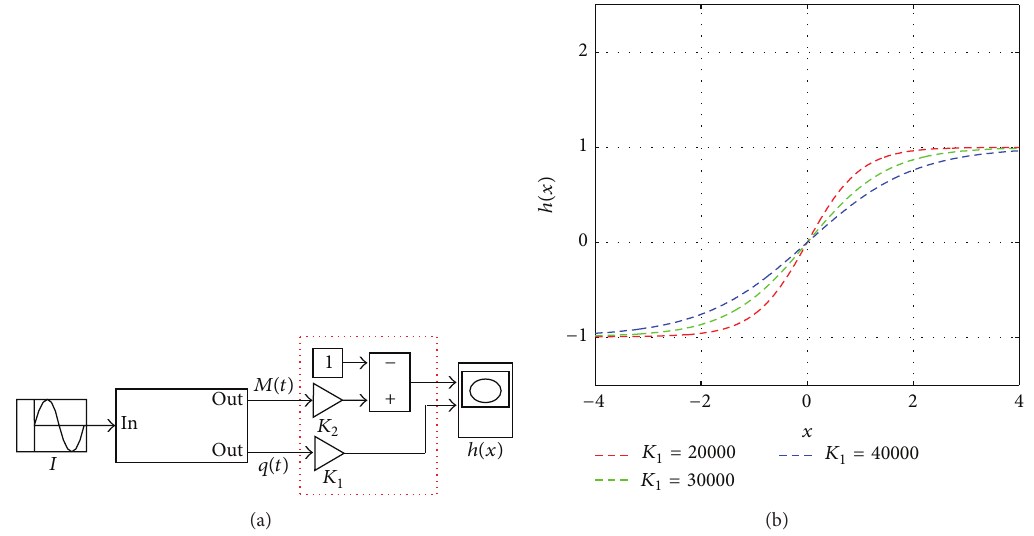
Figure9:Theprinciplediagramofthememristiveactivationfunctioninthehiddenlayer.(a)TheSimulinkmodelofthememristiveactivation function in the hidden layer. (b) The curve of the memristive activation function ℎ(𝑥) .